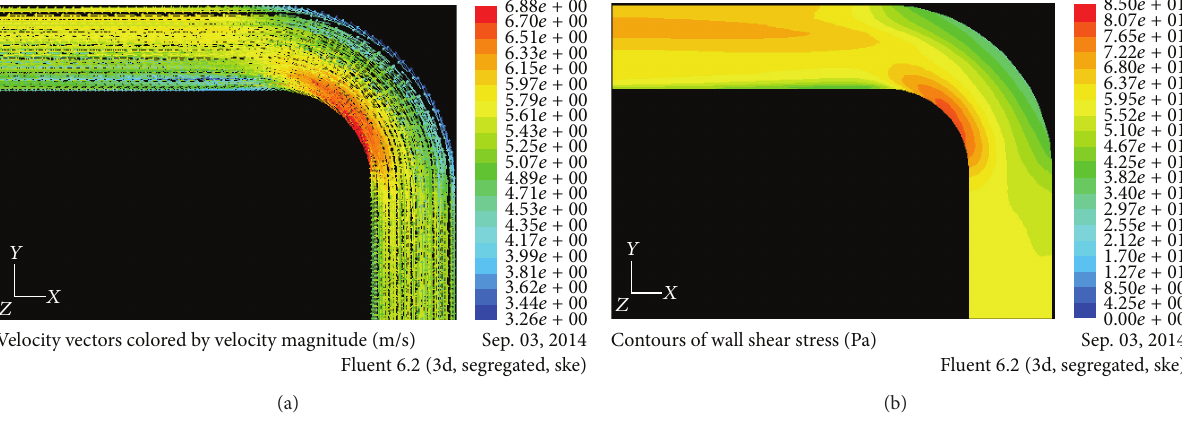
Figure 4: The three-dimensional distributions of fluid flow velocity and shear stress at elbow with the flow velocity of 5.31 m/s: (a) the distribution of fluid flow velocity and (b) the distribution of shear stress.